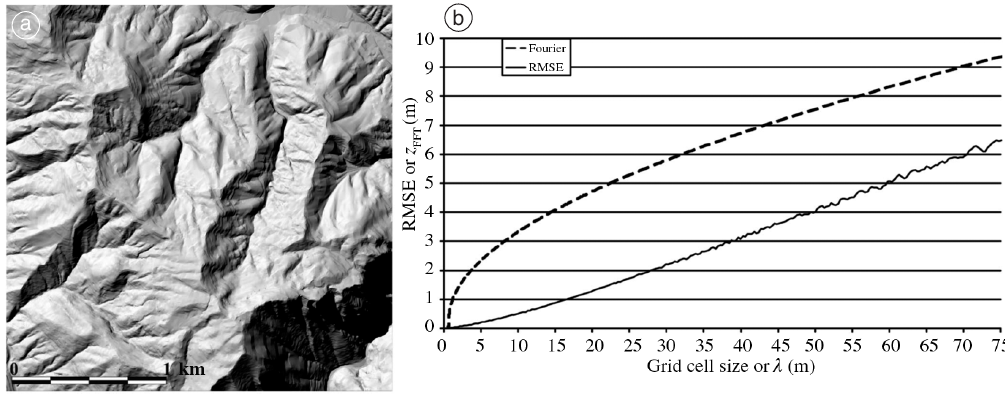
Fig. 8a,b. Comparison between the FFT and the RMSE. a) Shaded-relief image of the tile used as a test site inside the Friuli Region (bottom left coordinates: x = 825000 m; y = 5130000 m in UTM WGS84 zone 32). b) Plot of the elevation RMSE versus grid cell size δ x (solid line) and of the error in elevation z FFT as estimated by the FFT (dashed line) versus the cut-off wavelengths λ of the landscape